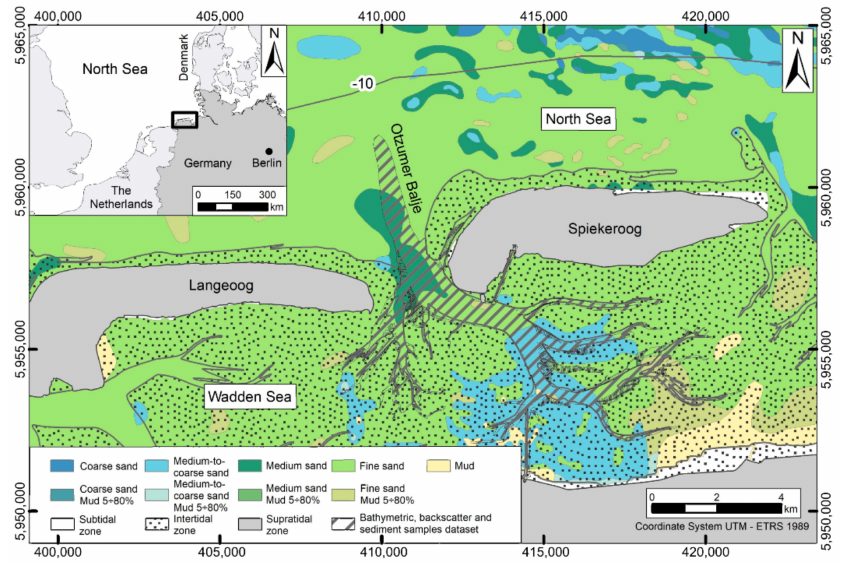
Figure 1. Location of Otzumer Balje and general sediment distribution according to the Figge classification